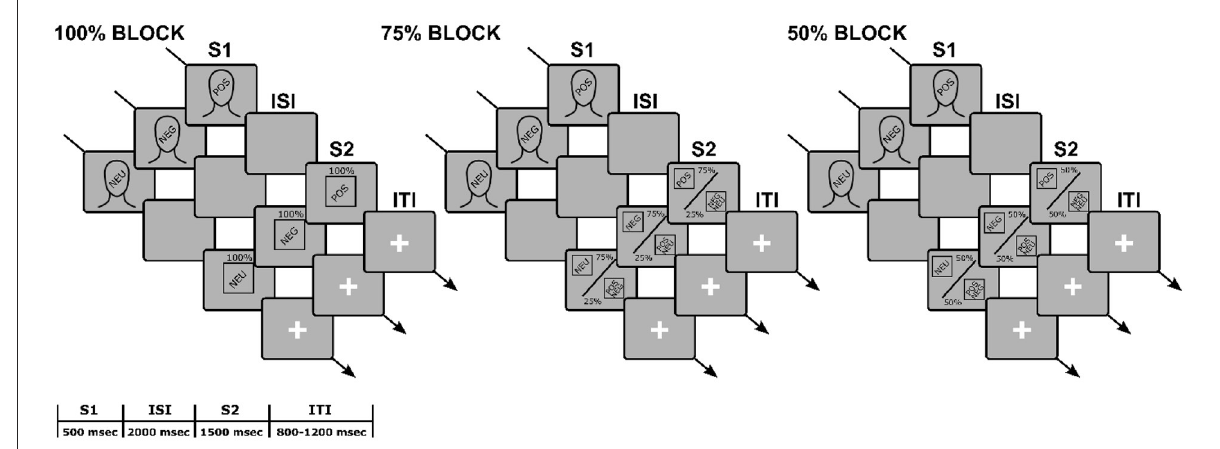
FIGURE1 Schematic representation of the experimental